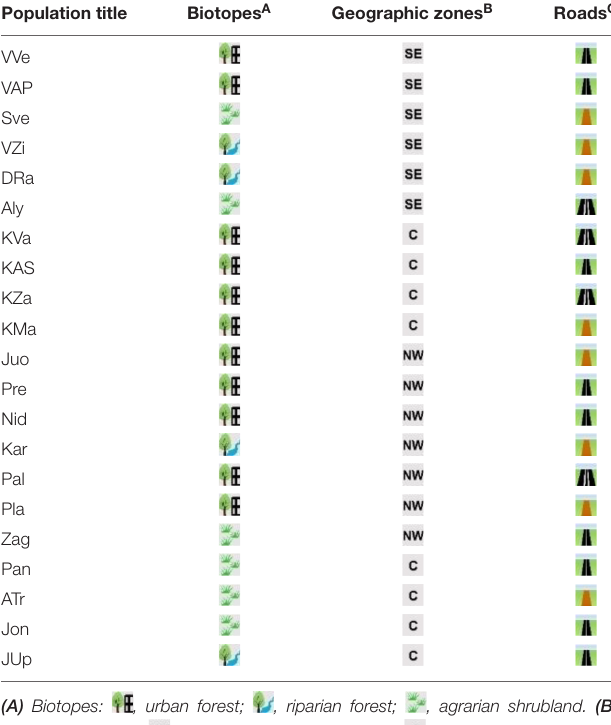
TABLE 1 | Characteristics of sites with Impatiens parviflora